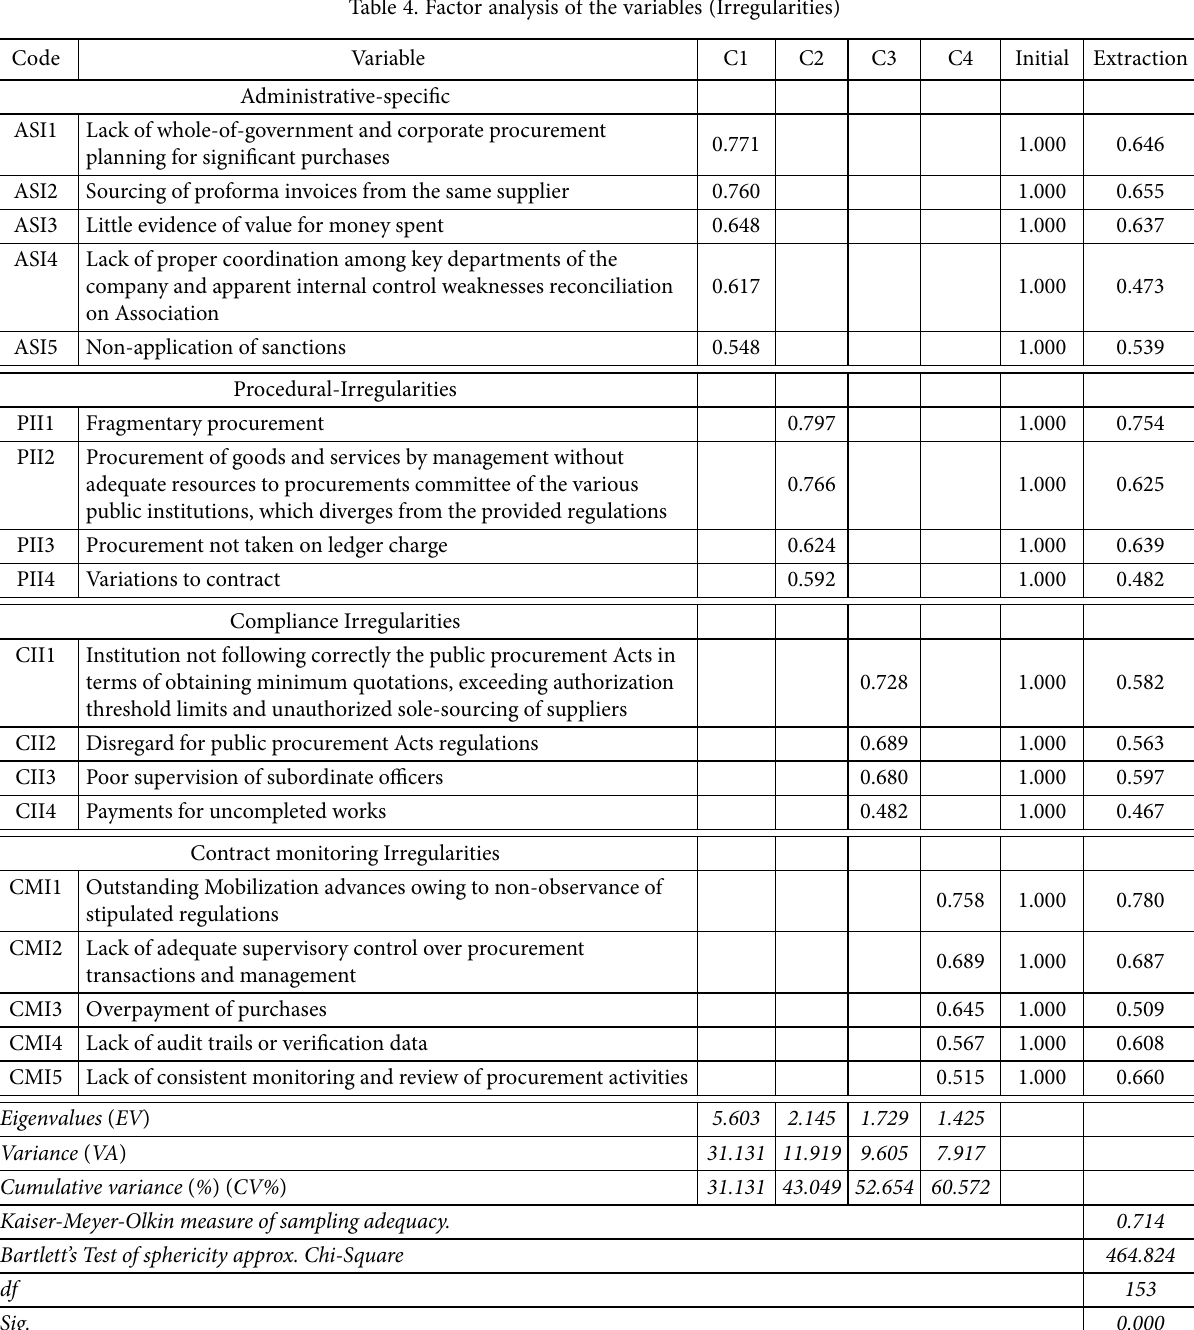
Table 4. Factor analysis of the variables